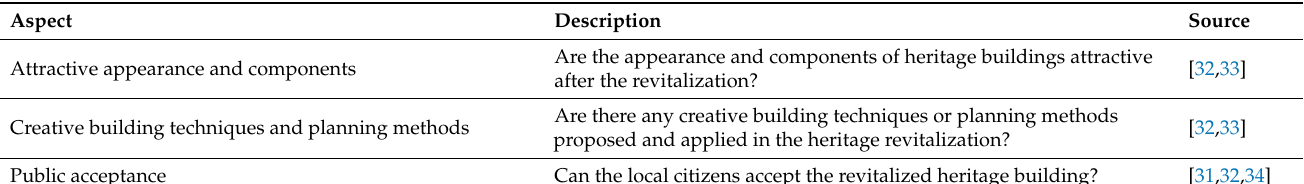
Table 2. The assessment of the effectiveness of heritage revitalization in community planning.